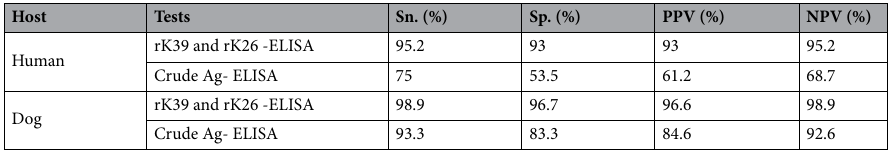
Table 3. Sensitivity, specificity, positive predictive value, and negative predictive value of Crude Ag- ELISA and mixed rK39 and rK26 ELISA tests in comparison with DAT for serodiagnosis of L. infantum infection on human and dog’s sera. Sn Sensitivity, Sp Specificity, PPV Positive predictive value, NPV Negative predictive value.